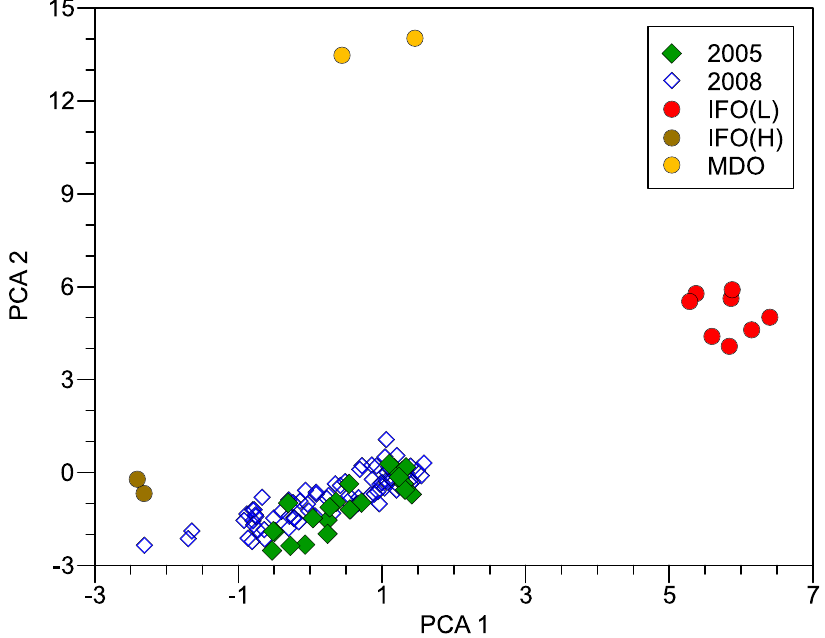
Fig 2. Summary of persistent biomarkers (hopanes and steranes) in oil and sediment. First and second principal components (PCA 1 and PCA 2) from the correlation matrix of normalized persistent biomarkers in all oil and sediment samples collected in 2004 or 2005 (blue) and 2008 (green). Source oils were light and heavy intermediate fuel oil [IFO(L) and IFO(H), respectively]. Marine diesel oil (MDO) was also spilled by the S . Ayu . References are off-scale low (near PCA 1 = − 21). The PCA 1 explained 51% of the variance and PCA 2 explained 19% of the variance.